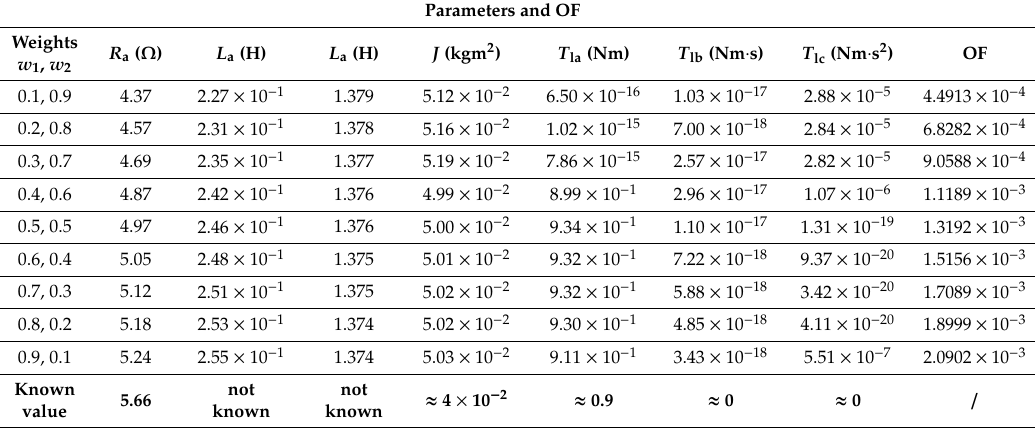
Table 21. Calculated parameters with di ff erent weights using RK for MD2 (mean values for 50 independent runs).